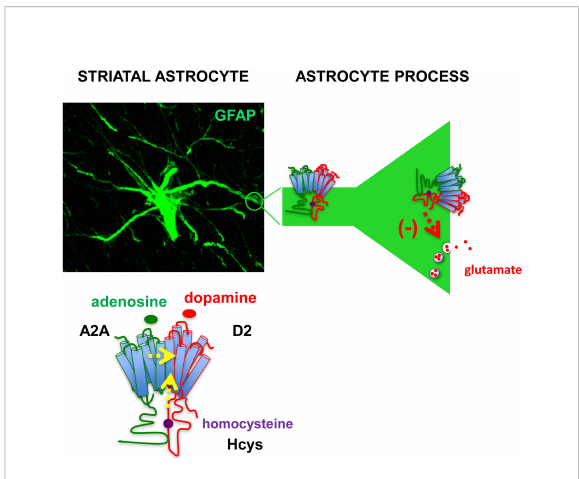
FIGURE 6 Representation of astrocytic A 2A -D 2 receptor heteromers in the striatum. A confocal image showing immuno fl uorescence staining of an astrocyte with the astrocyte marker Glial Fibrillary Acidic Protein (GFAP) in a striatal slice from adult rat. The presence of A 2A -D 2 receptor heteromers was demonstrated in striatal astrocytes both on perisynaptic processes and astrocyte branchlets (42, 137). Activation of the A 2A receptor in the heteromer prevented the effect of D 2 receptor activation (42); intracellular homocysteine (Hcys) behaved as an allosteric antagonist of the D2 receptor while maintaining A 2A -D 2 interaction (136). The heteromers were involved in the control of glutamate release from the processes (42, 136). The fi ndings suggest that A 2A -D 2 receptor heteromer may play crucial roles to control glutamatergic transmission in striatal functional modules, supporting exploration of strategies targeting at the heteromers to address neurodegenerative and functional striatal disorders. Yellow arrows: allosteric antagonism; red arrow: inhibition of vesicular glutamate